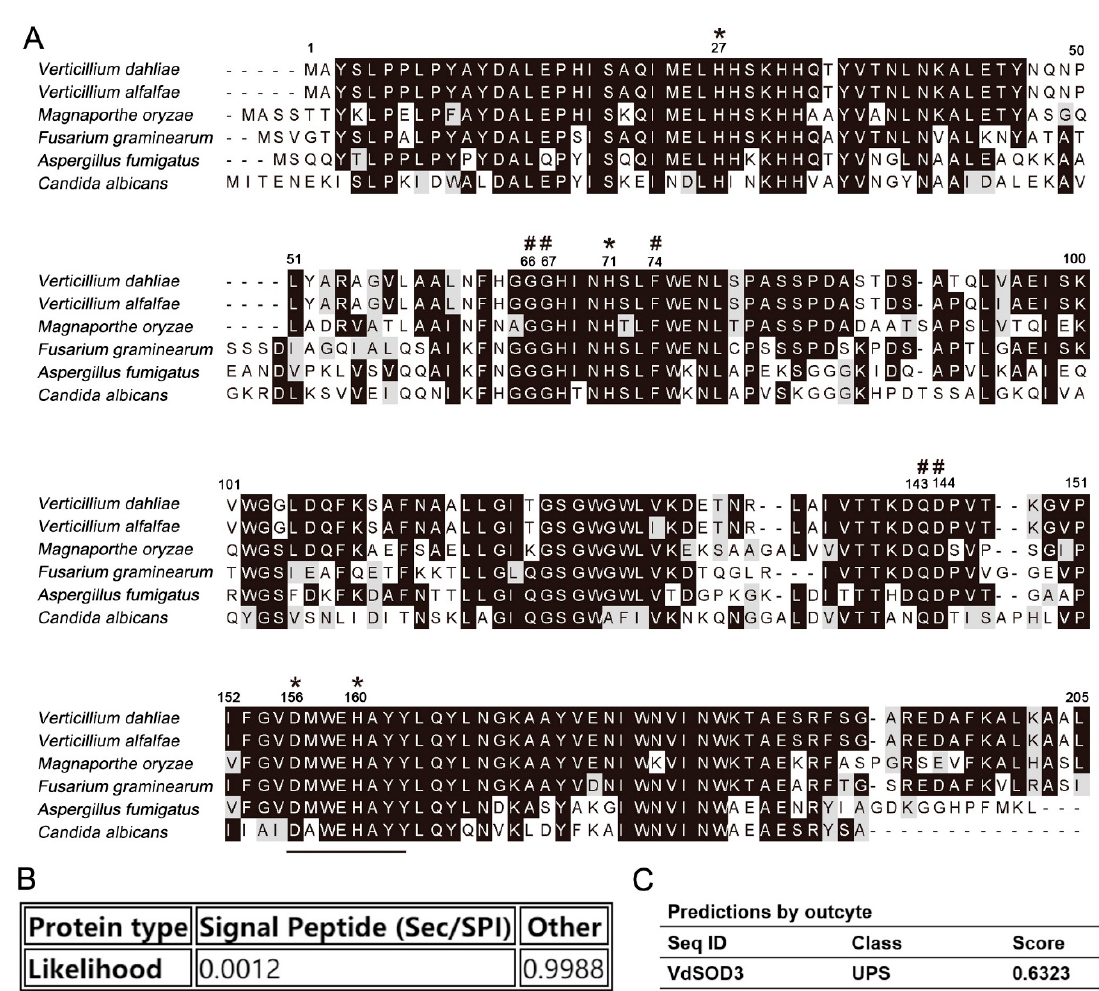
Figure 1. Bioinformatics analysis of Verticillium dahliae signal-peptide-lacking Manganese (Mn)-superoxide dismutase (SOD) (VdSOD3). ( A ) Alignment of protein sequence of VdSOD3 and its homologs from other fungi. Highly conserved residues are marked by a black background. The conserved SOD motif is underlined, Mn 2+ binding sites are marked by asterisks and specific residues for Mn-SOD are labeled by hashtags. The Genbank accession numbers of aligned sequences are listed as follows: Verticillium dahliae (VEDA_05933); Verticillium alfalfae (XP_003000585.1); Fusarium graminearum (ESU07439.1); Magnaporthe oryzae (EHA51830.1); Aspergillus fumigatus (XP_752824.1); Candida albicans (AAL08560.1). ( B ) Signal peptide prediction of VdSOD3 using SignalP 5.0 program. ( C ) Unconventional secretion of VdSOD3 predicted by OutCyte 1.0. UPS is short for unconventional protein secretions.